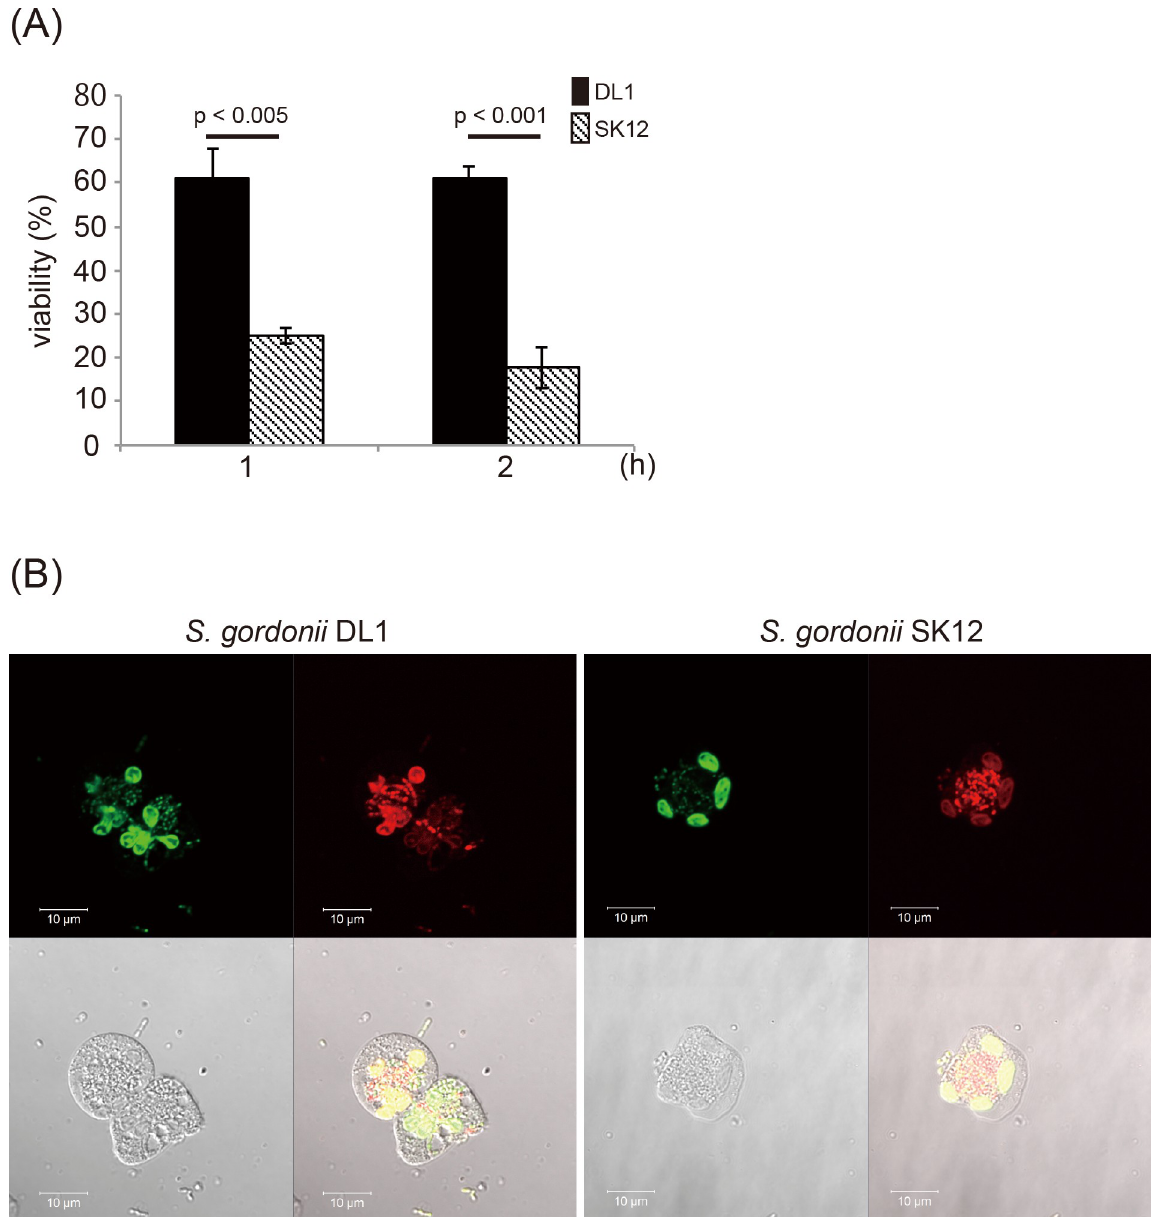
Fig 1. Bactericidal assay of Streptococcus gordonii strains treated with human polymorphonuclear leukocytes (PMNs). (A) Streptococcus gordonii DL1 (1 × 10 6 cells) and SK12 (1 × 10 6 cells) were incubated with or without human PMNs (5 × 10 6 cells) for 1 or 2 h at 37˚C on a rotator. The PMN/bacteria mixture was disrupted with sterile water and plated on BHI agar plates to enumerate live bacteria. Percent survival was calculated based on the number of colony forming units of bacteria mixed with PMNs compared to that of bacteria alone. The standard error is marked with error bars (n = 4). Statistical differences of the means of obtained values were evaluated by unpaired t -test. (B) S . gordonii DL1 and SK12 were exposed to PMNs for 2 h and stained with SYTO 9 and propidium iodide. Representative fluorescence micrographs of S . gordonii DL1 (a) and SK12 (b) are shown. Scale bar = 10 μ m. Green indicates live cells. Red indicates dead cells.